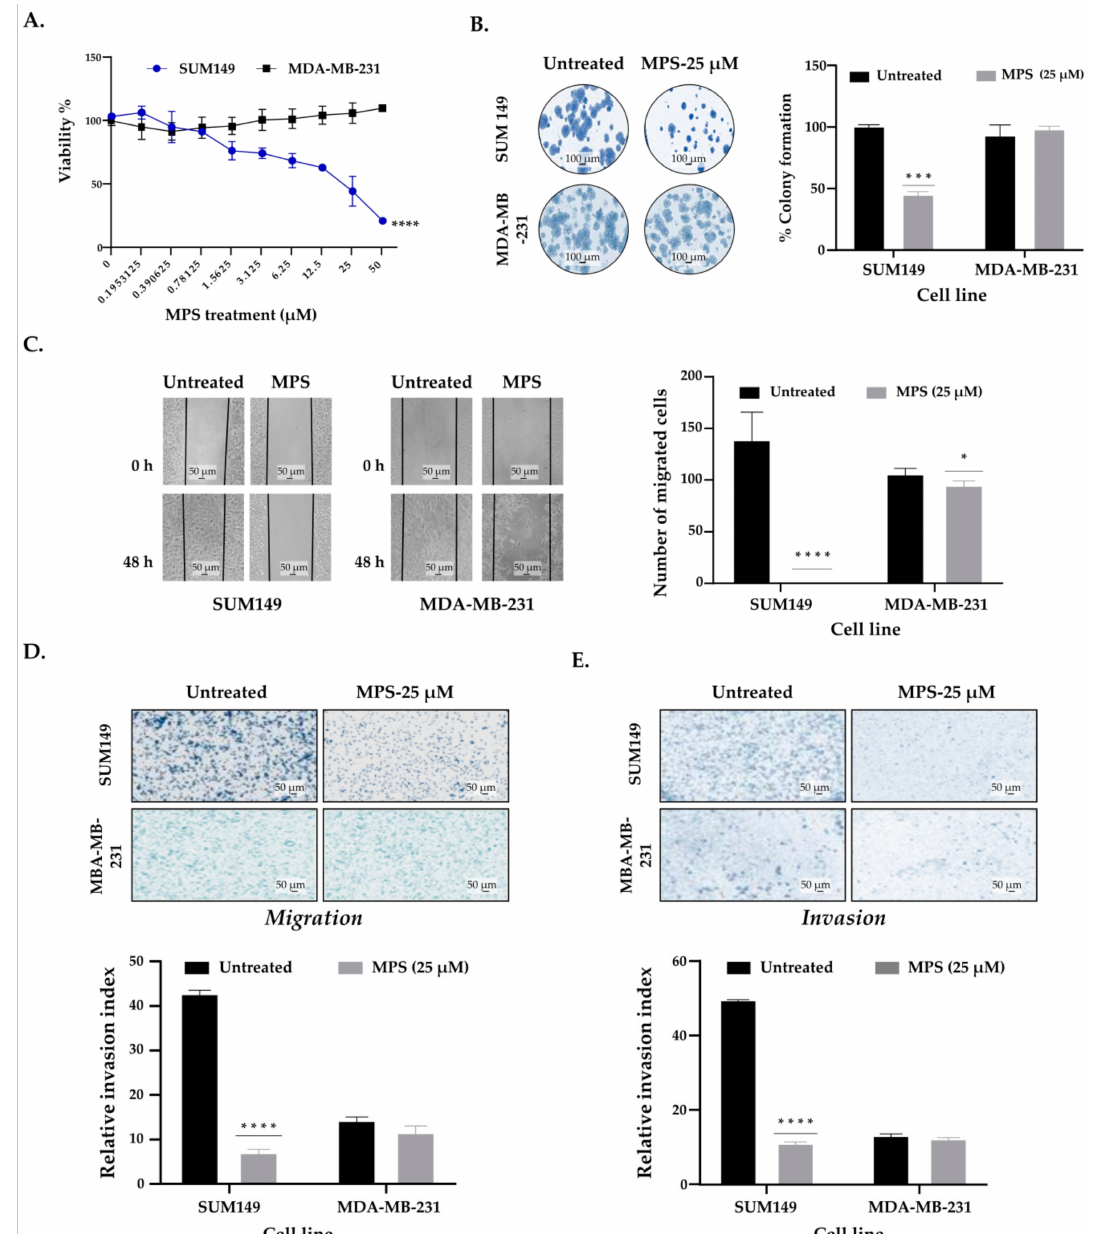
Figure 1. MARCKS promotes cell proliferation and motility of IBC. ( A ) MTT assay showed that MARCKS inhibition using 25 µ M MPS peptide induced cell growth inhibition only in SUM149 compared to MDA-MB-231 cells. ( B ) MPS reduced colony formation of SUM149 cells, but not in MDA-MB-231: representative images (left) and box plots (right). ( C ) Representative images of migration in scratch/wound-healing assay to evaluate the inhibitory effect of MPS peptide on IBC vs. nIBC cell migration (left). Each confluent monolayer was wounded linearly then treated with MPS (25 µ M), cell morphology and migration were observed and photographed at regular intervals, and the number of the migrated cells into the cell-free zone was calculated at 48 h compared to 0 h. ( D ) Similar to ( C ) but using the transwell migration assay. Migration was stained and measured after 24 h: representative images (top) and box plots (bottom). ( E ) Representative images of Matrigel invasion in chambers demonstrating the inhibitory effect of MPS in IBC cells (top) and box plots (bottom). Data were represented as mean ± SD. * for p ≤ 0.05, *** p ≤ 0.001 and **** p ≤ 0.0001, (3